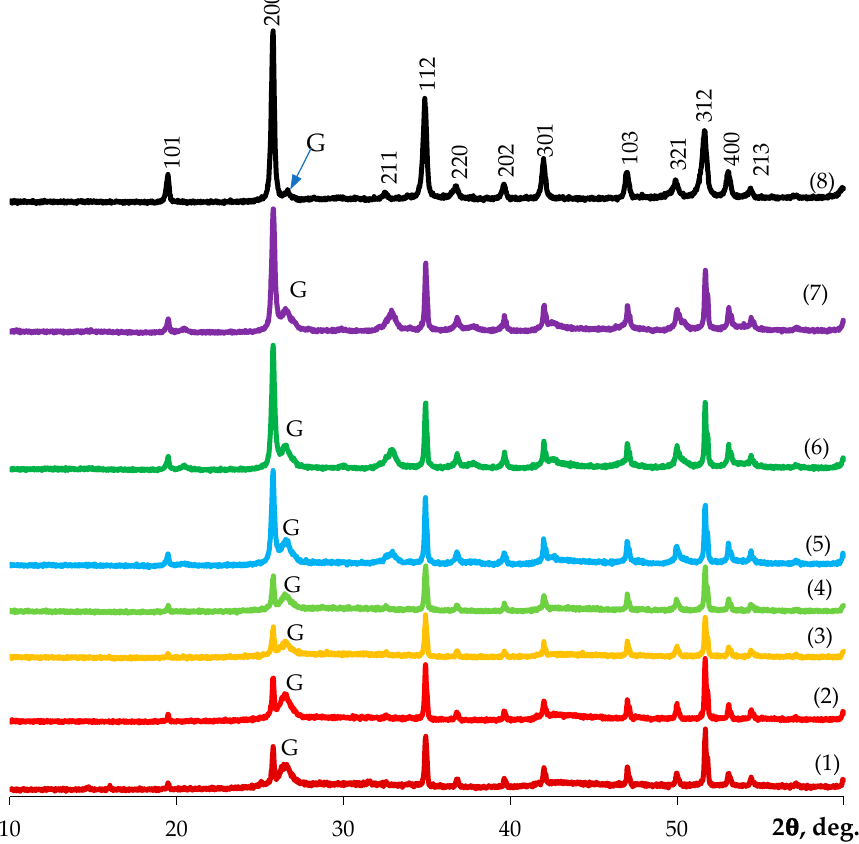
Figure 8. XRD data for the ceramic after irradiation (1) and after annealing at 200 ◦ C (2), 300 ◦ C (3), 400 ◦ C (4), 500 ◦ C (5), 600 ◦ C (6), and 700 ◦ C (7). (8) XRD curve from the nonirradiated ceramic